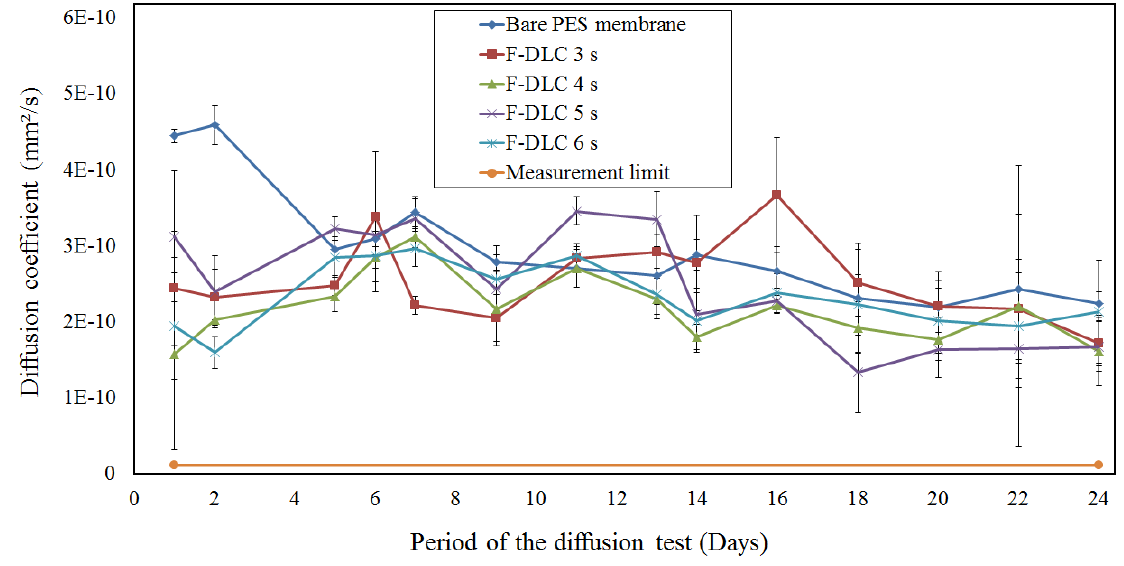
Figure 10. Diffusion coefficient of the membrane for 24